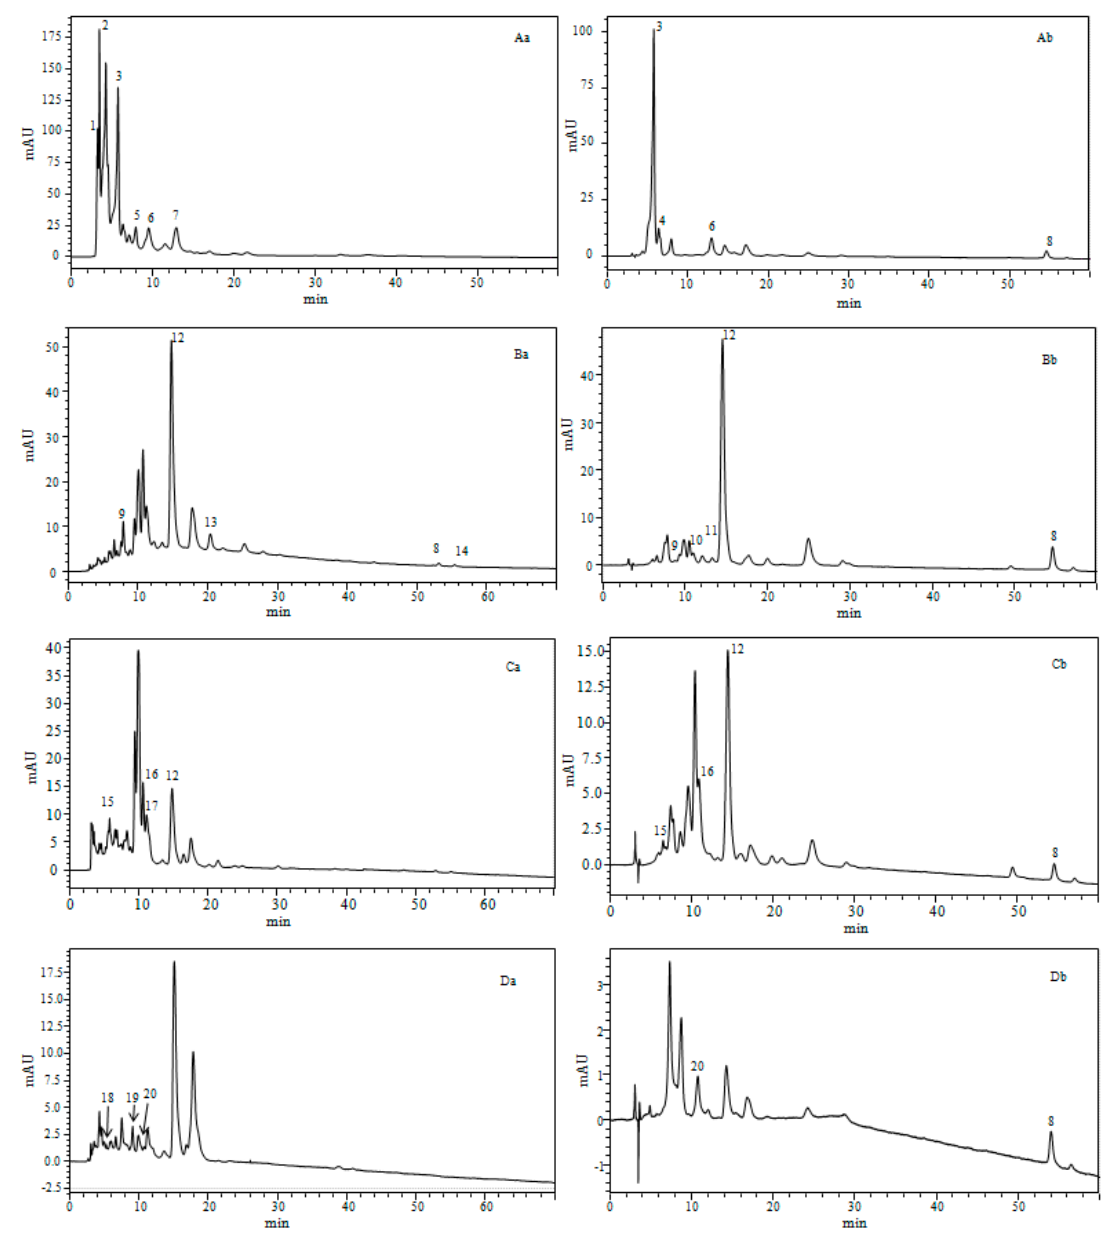
Figure 3. Chromatogram obtained by HPLC–PDA–MS (APCI) of the carotenoids for four species of microalgae: ( A ) Phaeodactylum tricornutum , ( B ) Nannochloris sp, ( C ) Tetraselmis suecica , and ( D ) Nannochloropsis gaditana . Chromatographic conditions: See text. With “a” for dry biomass and “b” crude liquid. Peak identification and characterization are given in Table 5 ( λ = 450 nm).